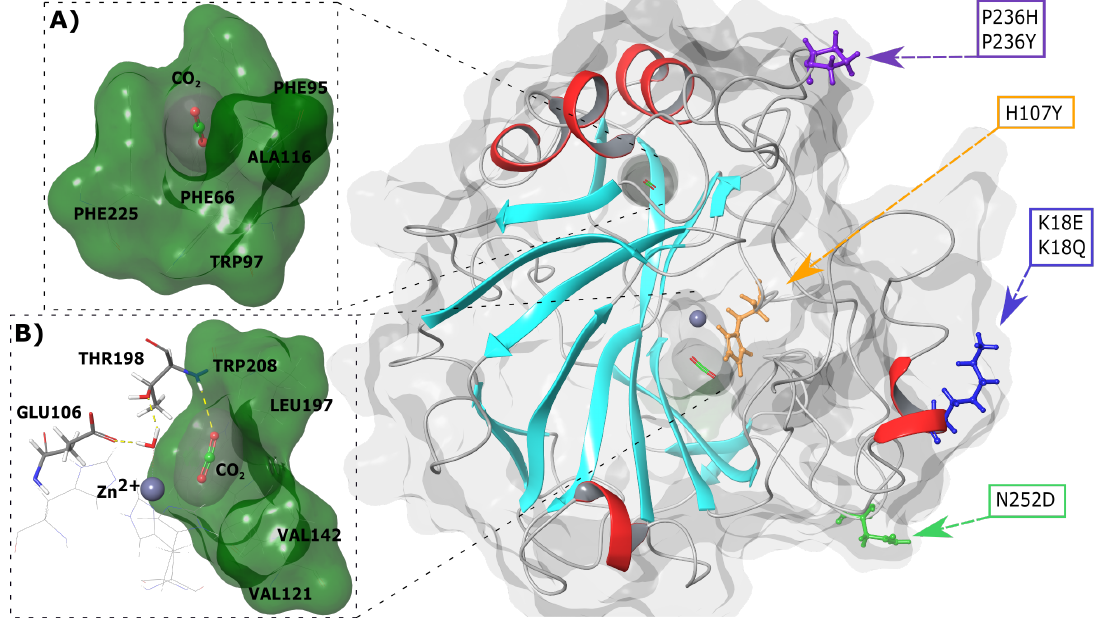
Figure 1. 3D structure of human CA-II WT protein and SNV locations. ( A ) Secondary CO 2 binding pocket. ( B ) Primary CO 2 binding pocket. Cyan and red secondary structure represents beta sheets and helices, respectively. The grey sphere represents the Zn 2 + . Representations were generated using Schrödinger Maestro and